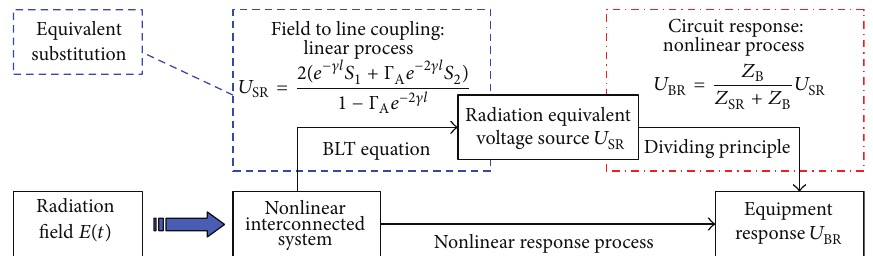
Figure 3: Radiation response process for nonlinear interconnected